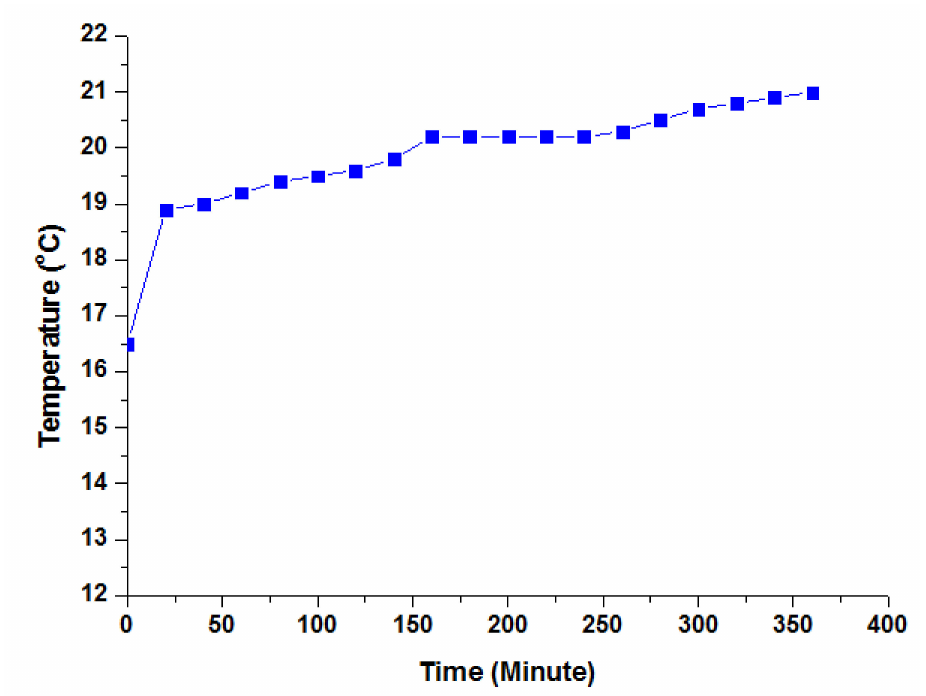
Figure 13. Changes in temperature of air leaving the FCU during discharging